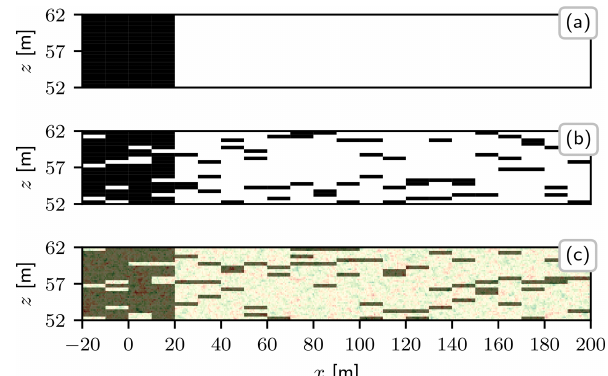
Figure 5. Realizations of hydraulic conductivity structures. (a) Deterministic zones (Module A), low K 1 in black, high K 2 in white. (b) Inclusions in deterministic zones (Modules A+B); vol- ume fraction of inclusions p = 15%, inclusion lengths I h = 10m, I v = 0 . 5m. (c) Inclusions in deterministic zones and subscale het- erogeneity (Modules A+B+C); correlation lengths λ h = 2 . 5m, λ v = 0 .